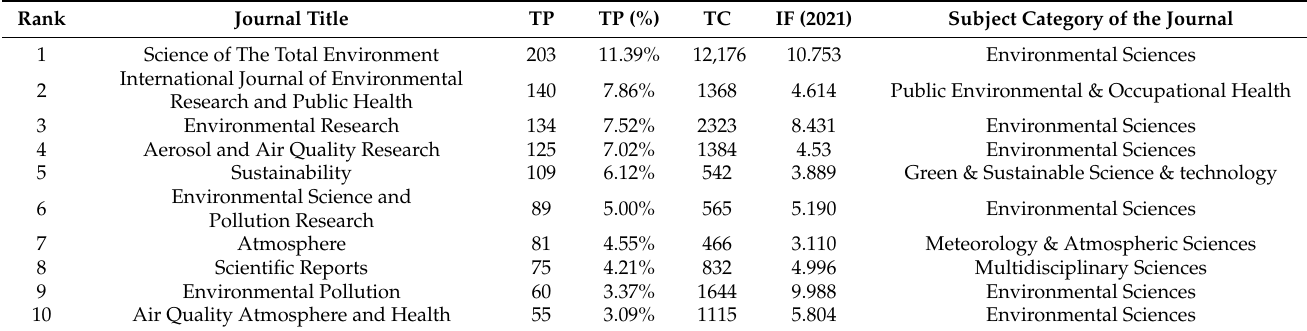
Table 2. The top 10 most active journals in terms of